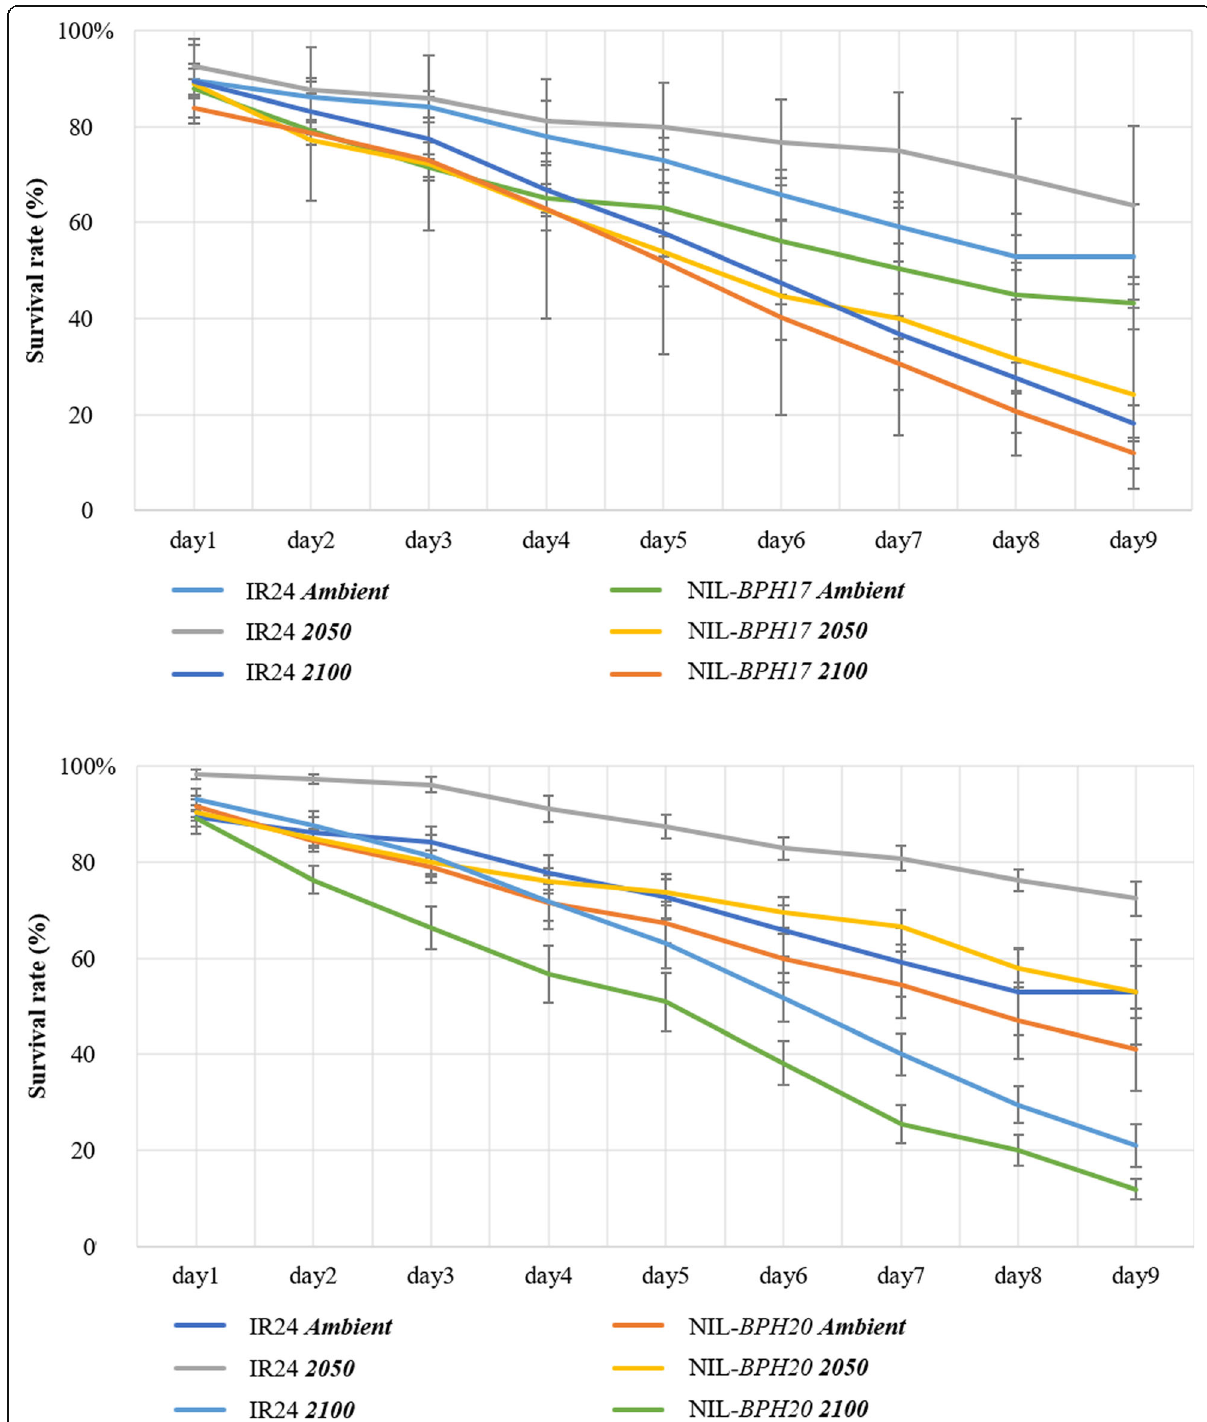
Fig. 4 The nymph survival rate of N. lugens feeding on IR24 and NILs under different environments. a IR24 and NIL- BPH17 . b IR24 and NIL-